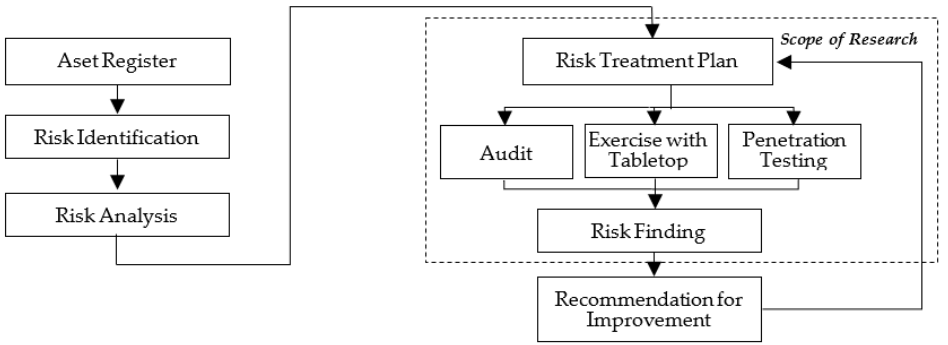
Figure 7. The Risk Management Flow Chart’s Scope of the Risk Treatment Plan Testing Architecture System.